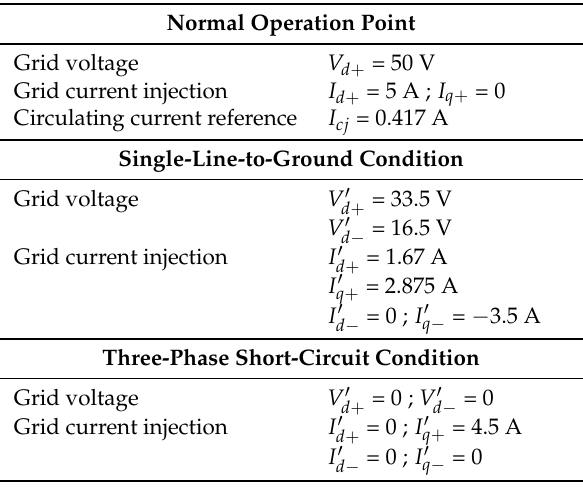
Table 3. Possible operation points of the MMC.